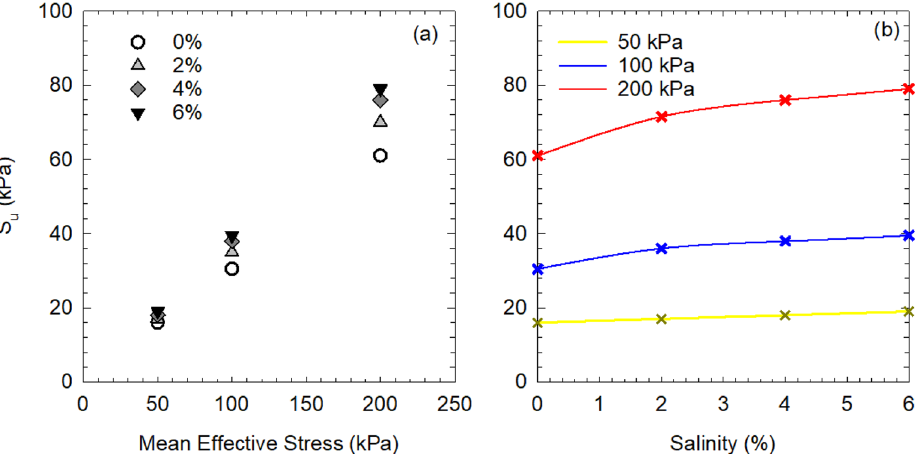
Figure 7. Undrained shear strength of soft marine soil versus ( a ) mean effective stress with different salinity, and ( b ) porewater salinity under different mean effective